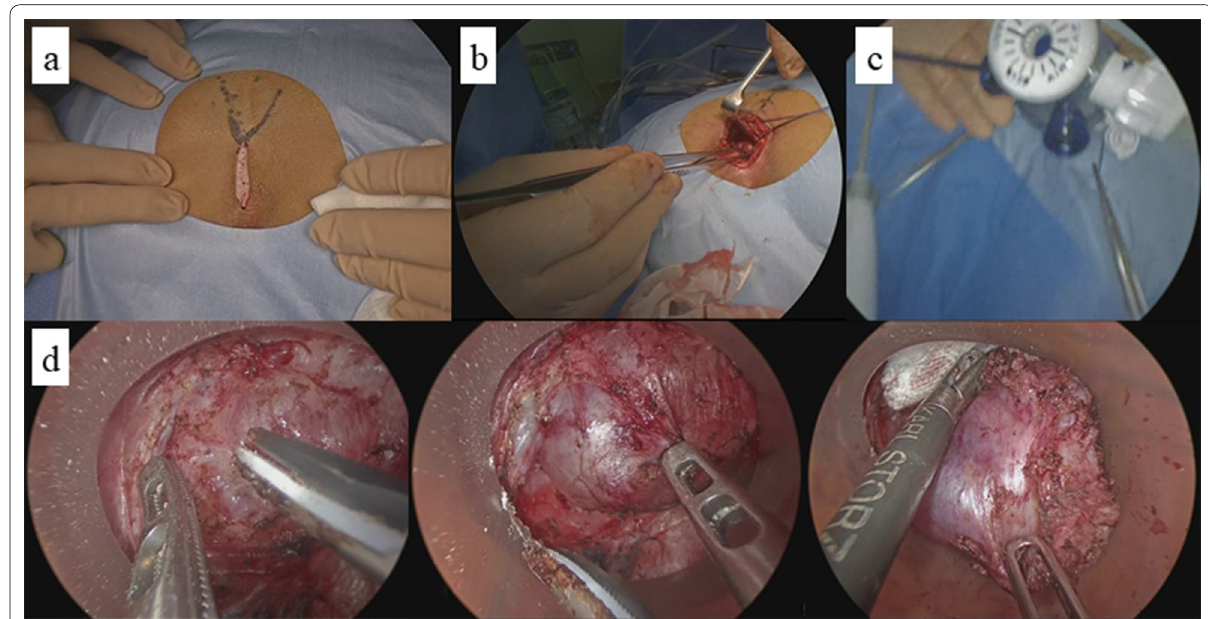
Fig. 4 A skin incision measuring approximately 3 cm was made from the coccyx to the anus ( a ). It was difficult to confirm the deep part of the tumor through direct visualization ( b ). The tumor was resected endoscopically using the GelPOINT ® Path and AirSEAL ® System ( c , d )